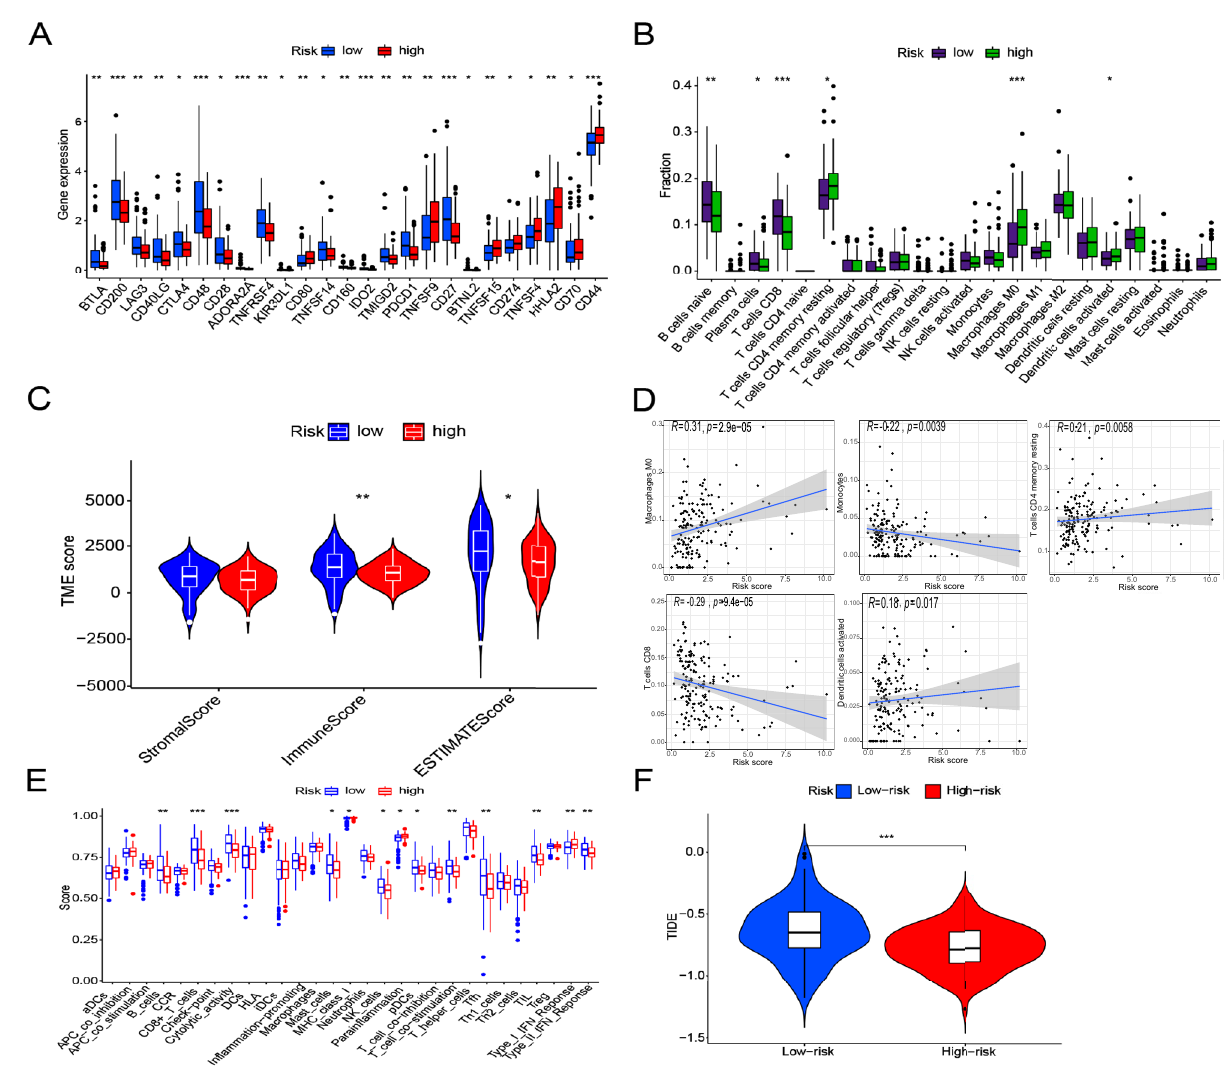
Figure 7. Immune landscape of the prognostic model. *, **, ***, represent P < 0.05, P < 0.01 and P < 0.001. ( A ) Boxplot showing the differential expression of immune checkpoint genes between the high- and low-risk groups. ( B ) Boxplot showing the differential expression of immune cells between the high- and low-risk groups. ( C ) Violin plot showing differences in the immune infiltration scores between groups. ( D ) Correlation of immune cells and risk score. ( E ) Boxplot showing differential expression of immune cell subpopulations and immune cell-related functions in high- and low-risk groups. ( F ) Violin plot of Tumor Immune Dysfunction and Rejection (TIDE) scores in the high- and low-risk